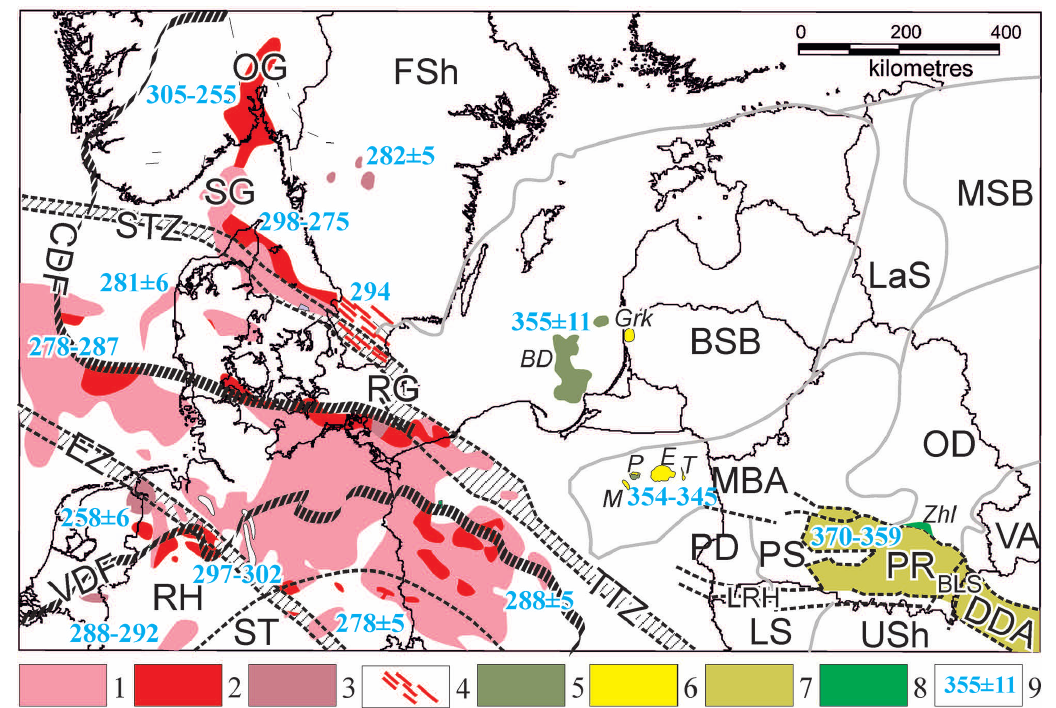
Fig. 10. Distribution of Permo-Carboniferous igneous rocks. Late Carboniferous–Permian igneous rocks: 1, extrusions, 2, intrusions, 3, sills, 4, dolerite dykes; Early Carboniferous igneous rocks: 5, sills ( BD , Baltic dolerites), 6, intrusions ( E , E ł k syenite, Grk , Girkaliai granite, M , Mlawa syenite, P , Pisz gabro, T , Tajno carbonatites); Late Devonian igneous rocks: 7, volcanic rocks; 8, ultramafic intrusions ( Zhl , Zhlobin); 9, age of igneous rocks (Ma). Compiled after Aizberg et al. 2001; Heeremans et al. 2004; Neumann et al. 2004; Krzemi ń ska & Krzemi ń ski 2012; Demaiffe et al. 2013. Major tectonic structures: BSB, Baltic Sedimentary Basin; BLS, Bragov–Loev Saddle; CDF, Caledonian Deformation Front; DDA, Dnieper–Donetsk Aulacogen; EZ, Elba Zone; FSh, Fennoscandian Shield; LRH, Lukau–Ratno Horst; LaS, Latvian Saddle; LS, Lublin Slope; MBA, Mazury–Belarus High; MSB, Moscow Sedimentary Basin; OD, Orsha Depression; OG, Oslo Graben; PD, Podlasie Depression; PR, Pripyat Rift; PS, Polessian Saddle; RG, Rønne Graben; RH, Rhenohercynian Zone; SG, Skagerrak Graben; ST, Saxoturingian Zone; STZ, Sorgenfrei–Tornquist Zone; TTZ, Teisseyre–Tornquist Zone; USh, Ukrainian Shield; VA, Voronezh Arch; VDF, Variscan Deformation